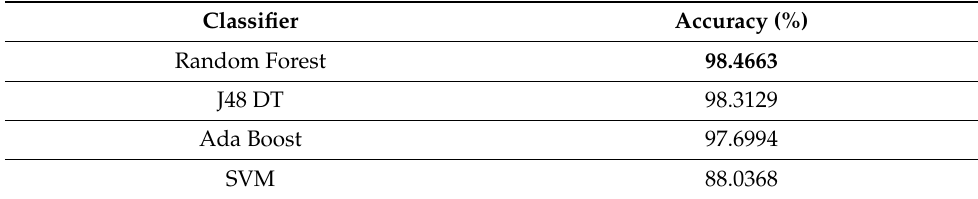
Table 17. Comparative results for the classifiers.